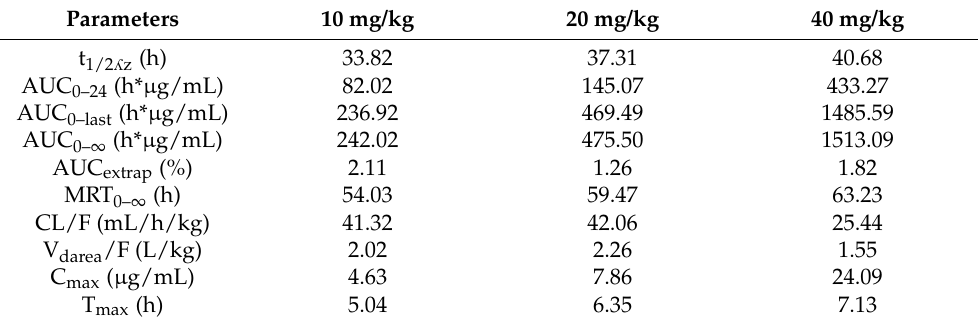
Table 2. MIC values of enrofloxacin for A. hydrophila and A. sobria isolated from fish farm.